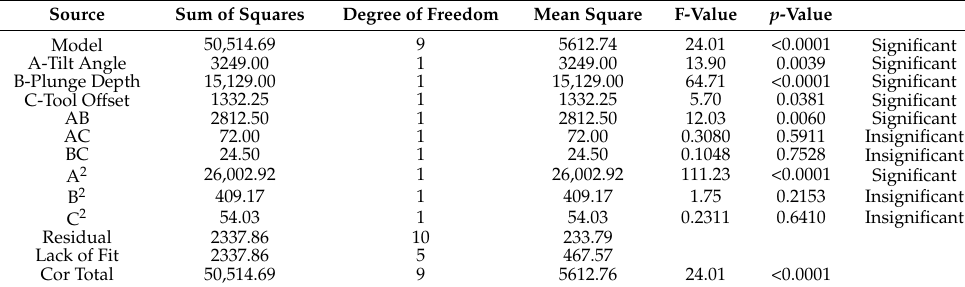
Table 8. Analysis of variance (ANOVA) test for the peak